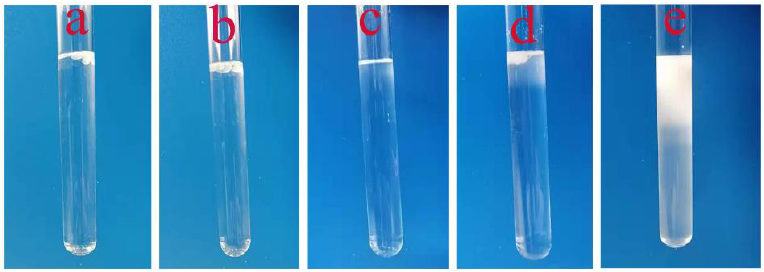
Figure 4. The Molau tests of ( a ) pure OBC, ( b ) pure POE-g-MAH, ( c ) pure PA6, ( d ) the uncompatibilized PA6/OBC blend, and ( e ) the 7 wt% POE-g-MAH compatibilized PA6/OBC blend (PA6/OBC/7).